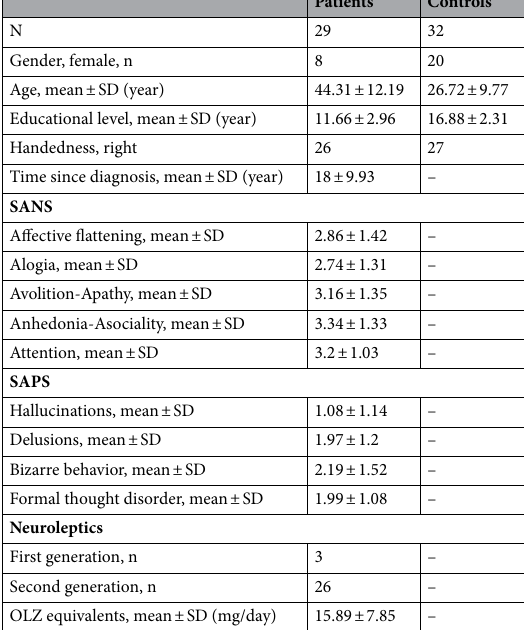
Table 1. Demographics and clinical characteristics of the sample at the time of